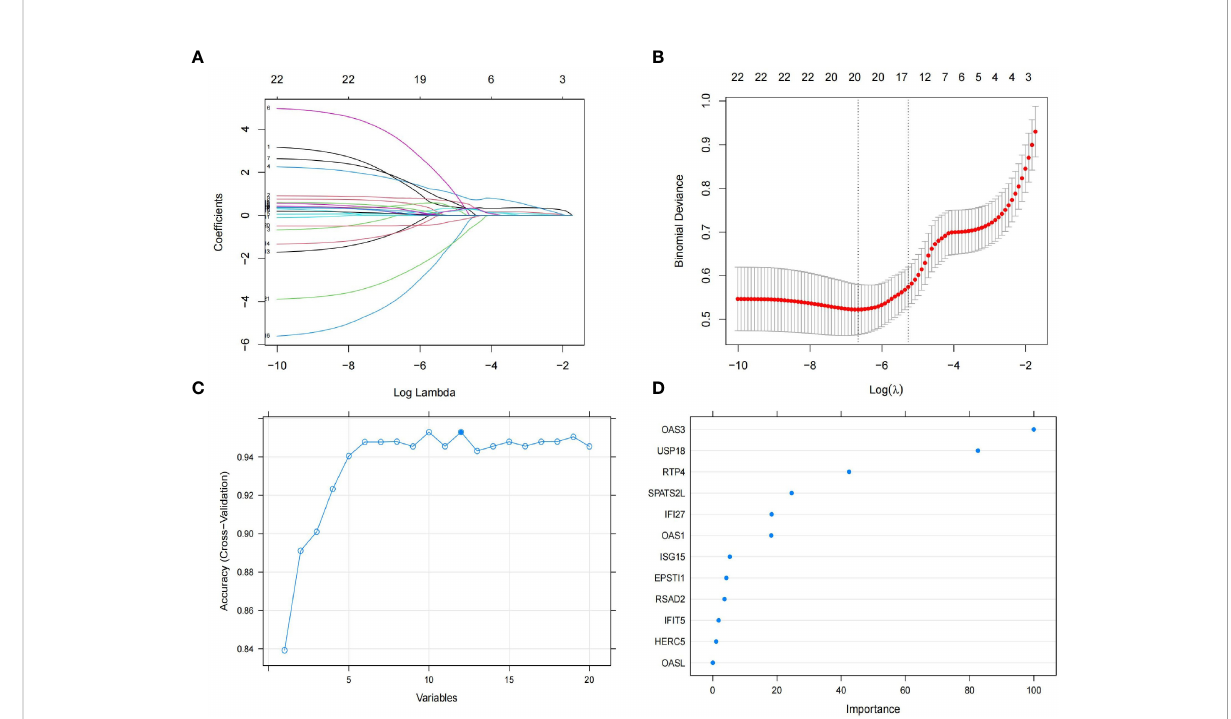
FIGURE 4 Feature selection. (A) The lasso regression curve of 22 DEGs. (B) The 10-fold cross-validation parameter ( l ) options. (C) The 10-fold cross- validation of RMSE of signature gene combination of RF-RFE. (D) Gene importance scores for random